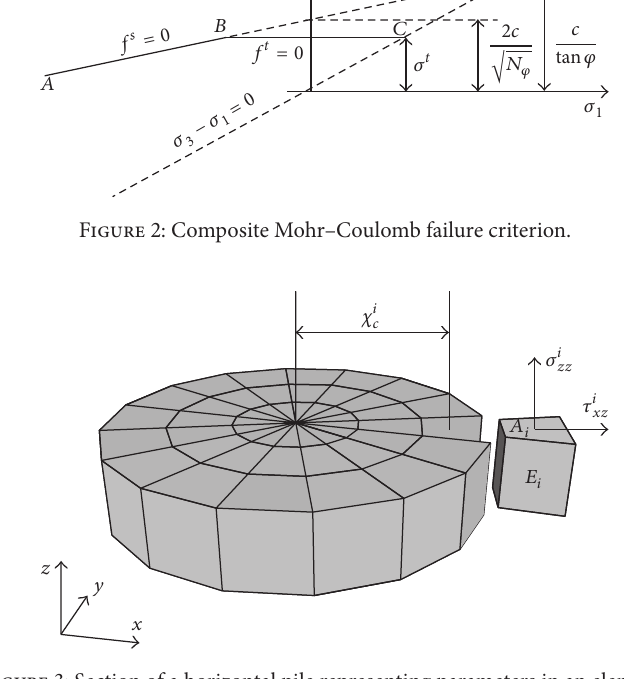
Figure 3: Section of a horizontal pile representing parameters in an